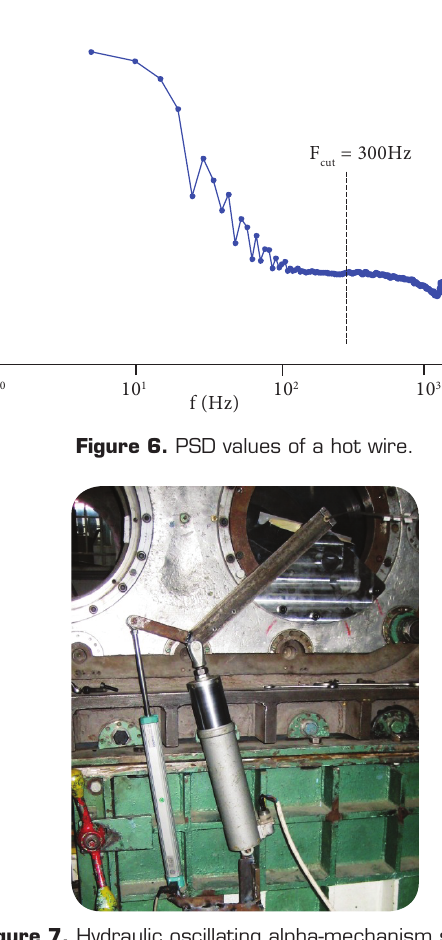
Figure 7. Hydraulic oscillating alpha-mechanism